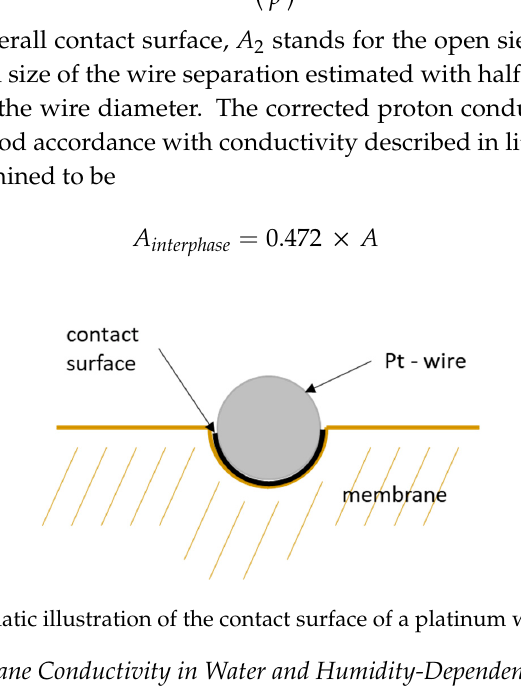
Figure 10. Calculated conductivity of Nafion 117 at 100 °C; blue: correction for humidity dependent membrane thickness and open mesh area; and black: correction for humidity dependent membrane thickness and immersed mesh area.